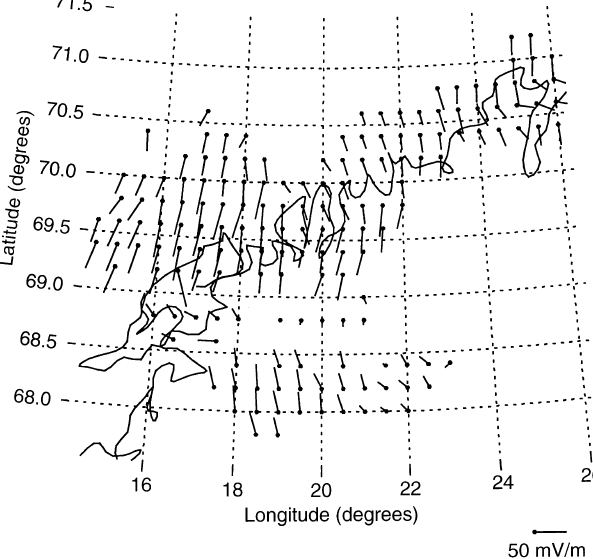
Fig. 4. STARE electric field data for 27 October 1979, 17:39 UT, with Scandinavian coastline (data courtesy of E. Nielsen, Katlenburg-